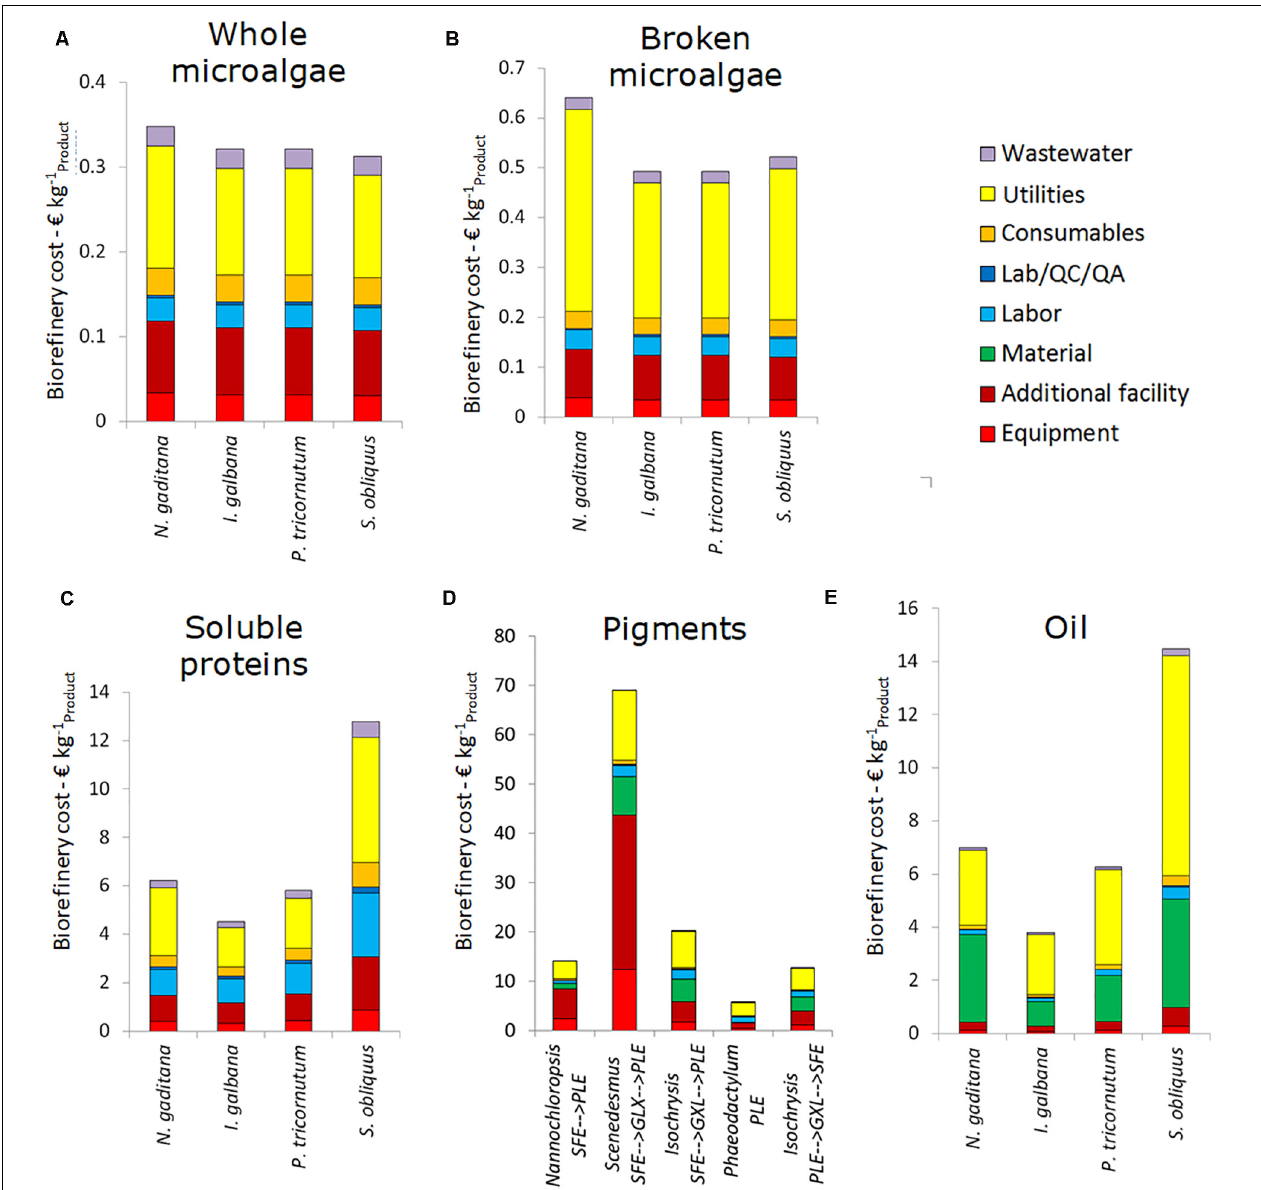
FIGURE 3 | Breakdown of the biorefinery costs (excluding cultivation) for the five single product value chain at 10 ktons y - 1 scale. (A) Whole microalgae, (B) Broken microalgae, (C) Soluble proteins, (D) Pigments, and (E) Oil. Data are expressed as costs per unit of main product. SFE, supercritical fluid extraction; GXL, gas expanded liquid extraction; PLE, pressurized liquid